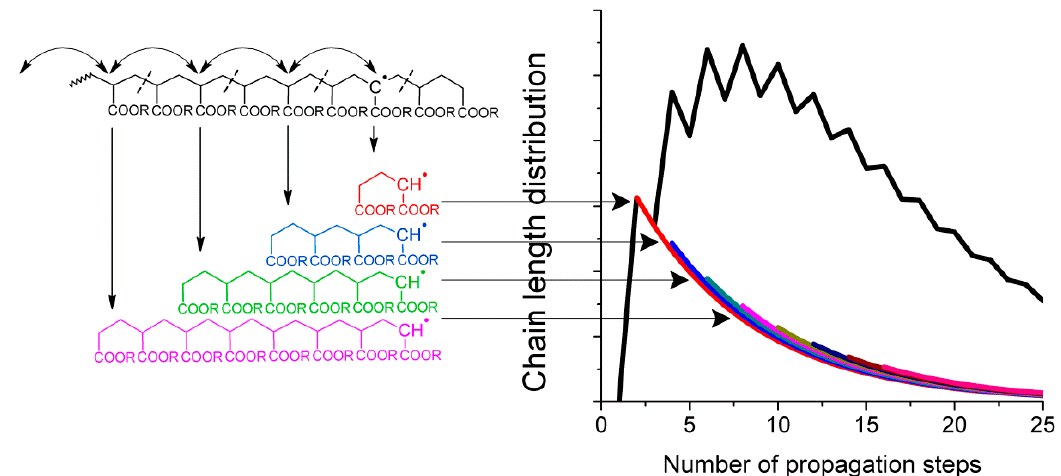
Figure 2. Example of hopping on molecular weight distribution. The hopping process leads to a distribution of mid-chain radicals, which after β -scission generates an initial distribution of chain lengths of radicals that can subsequently propagate (left). The final chain length distribution (bold black line, right) is given by the sum of the chain length distribution of each individual initiating species (colored lines, right).